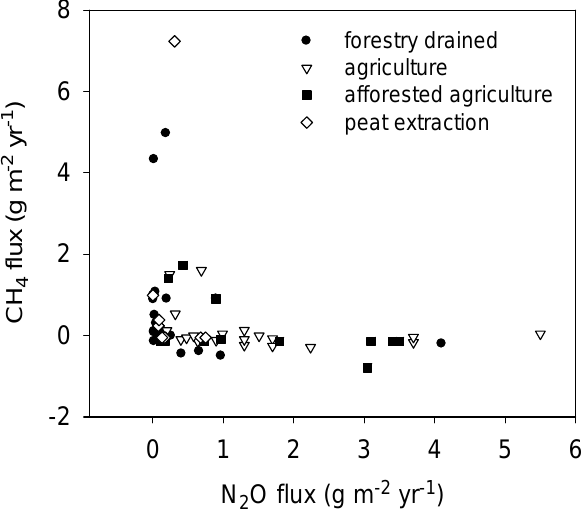
Fig 3. Fig. 3. Relationships between annual fluxes of N 2 O and CH 4 on drained peat soils (black circle=forestry drained, open trian- gle=agriculture, black square=afforested agricultural soils, open diamond=peat extraction